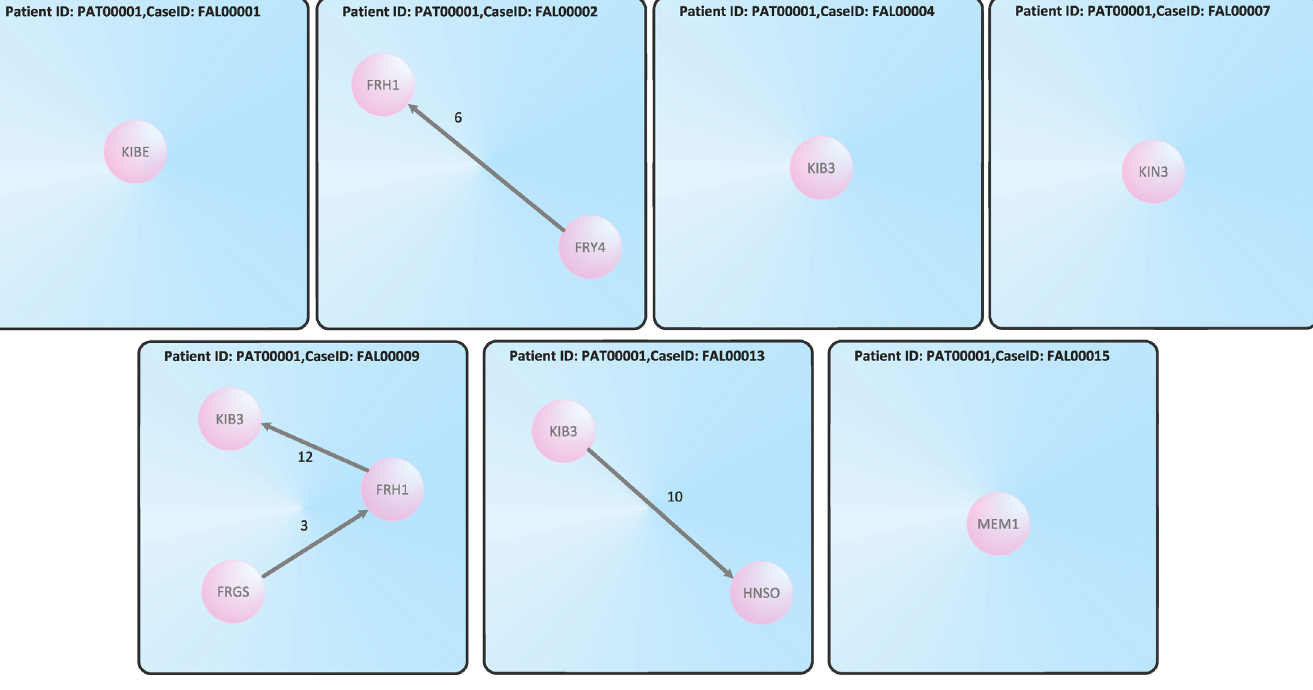
Fig 2. Individual treatment cycles for patient ID